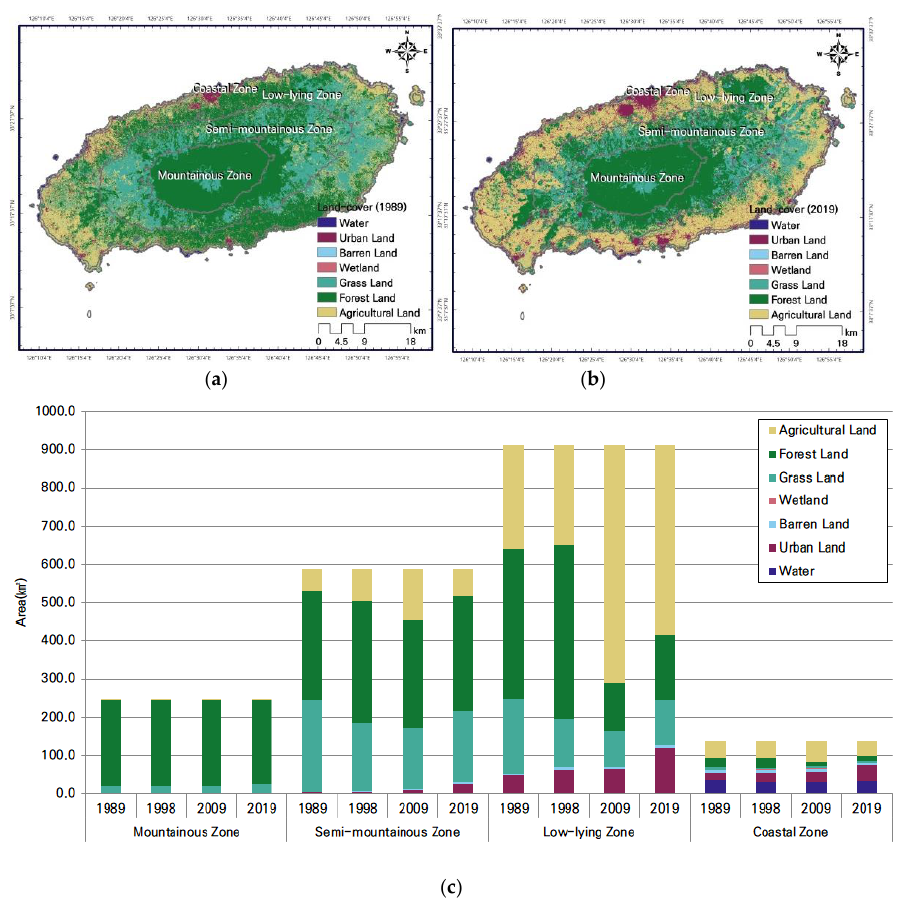
Figure 2. Changes in land-cover on Jeju, South Korea. ( a ) Distribution of land-cover types in 1989. ( b ) Distribution of land-cover types in 2019. ( c ) Changes in land-cover.